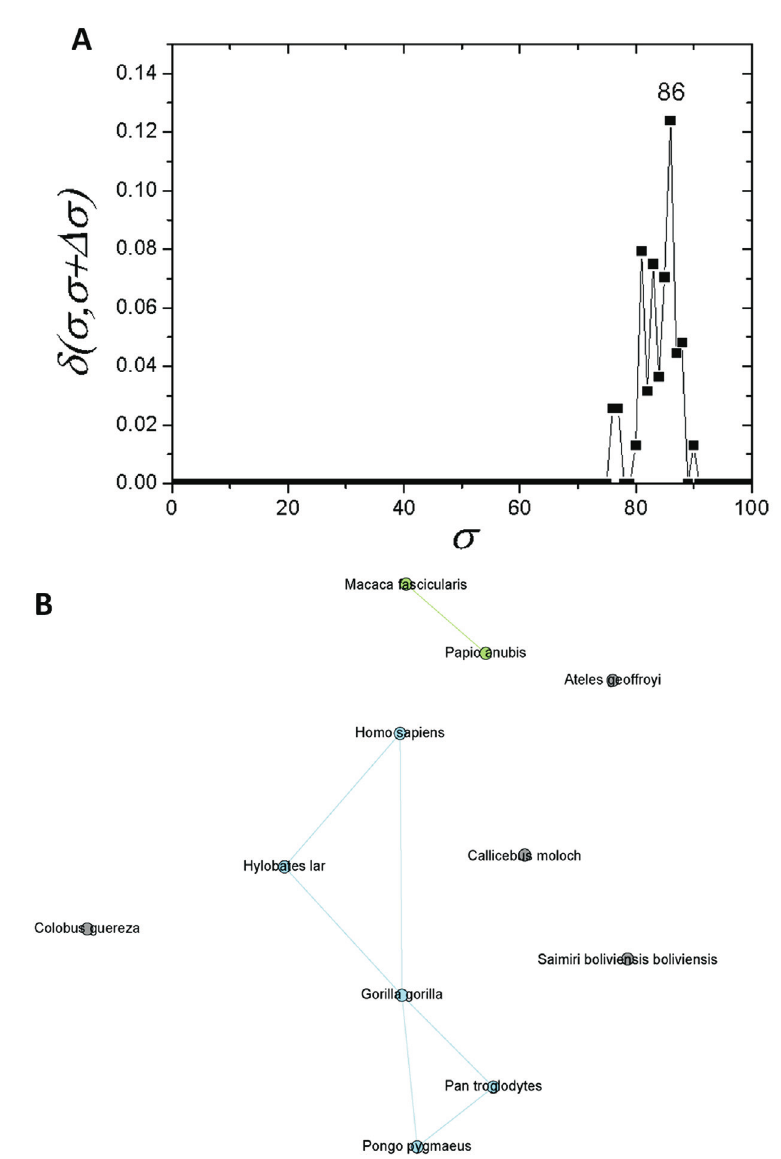
Figure 5 - Complex networks analysis. (A) Graph showing the (cid:5) -distance between networks formed by the apo E sequences from primates with (cid:3) cst =86% . (B) Network representation of apo E primate sequences at